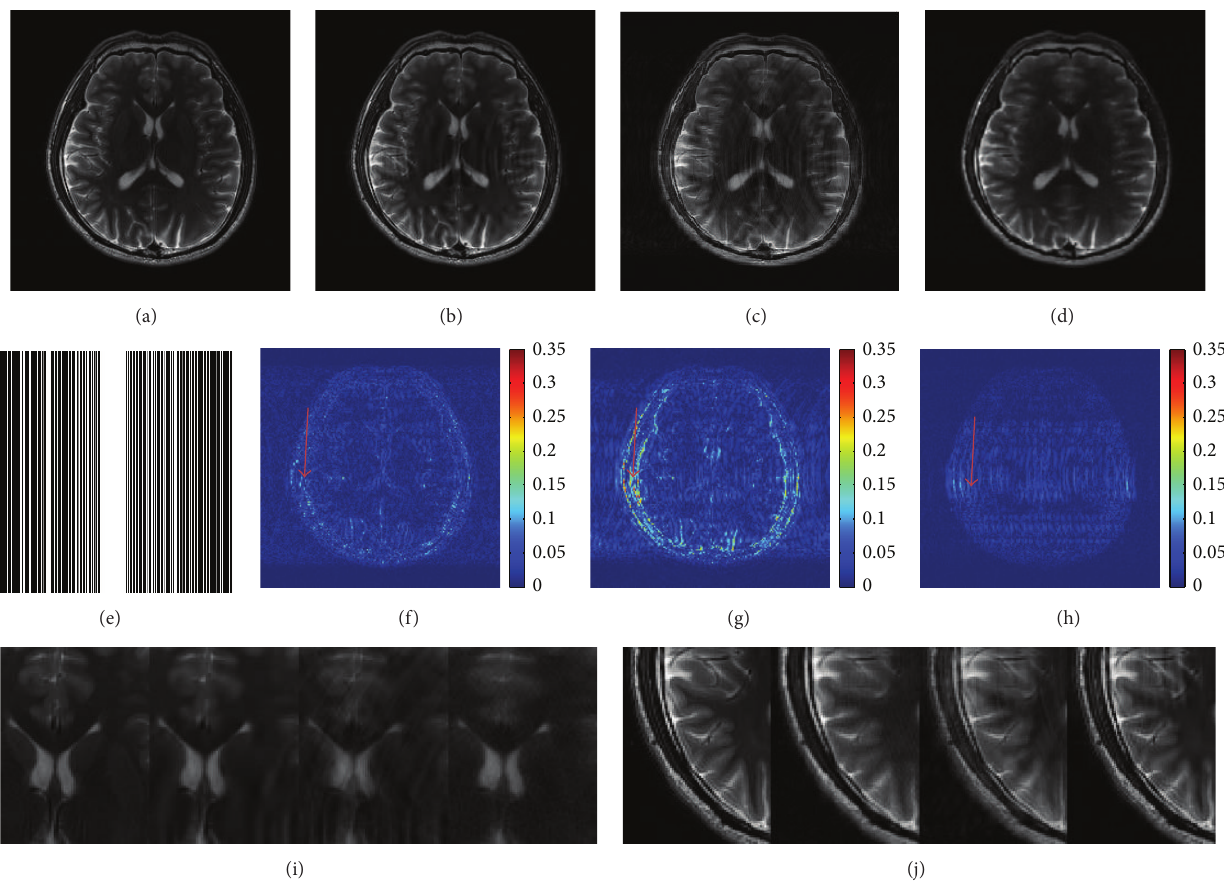
Figure 8: Reconstructed brain images at 40% undersampling. (a) The fully sampled image. ((b), (c), (d)) The reconstruction images using DLMRI, SHTGV, and DLTGV. (e) Mask data with 40% Cartesian sampling. ((f), (g), (h)) Reconstruction error magnitudes for DLMRI, SHTGV, and DLTGV. ((i), (j)) Enlargements of (a), (b), (c), and